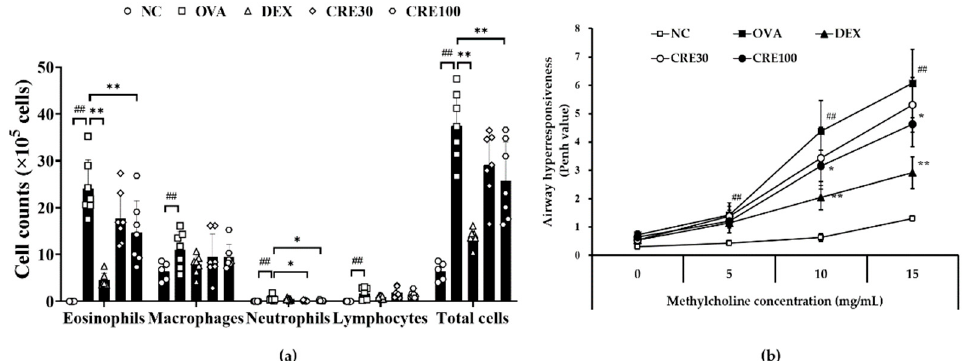
Figure 2. CRE inhibited inflammatory cell count and airway hyperresponsiveness (AHR) in animals with asthma. ( a ) Inflammatory cell counts in BALF, ( b ) AHR. NC: PBS treatment and PBS challenge; OVA: PBS treatment and OVA challenge; DEX: dexamethasone (2 mg/kg) treatment and OVA challenge; CRE30 and CRE100: CRE (30 mg/kg and 100 mg/kg, respectively) and OVA challenge. The values are shown as the mean ± SD ( n = 5–7). ## p < 0.01 versus NC; *, ** p < 0.05 and 0.01 versus OVA.